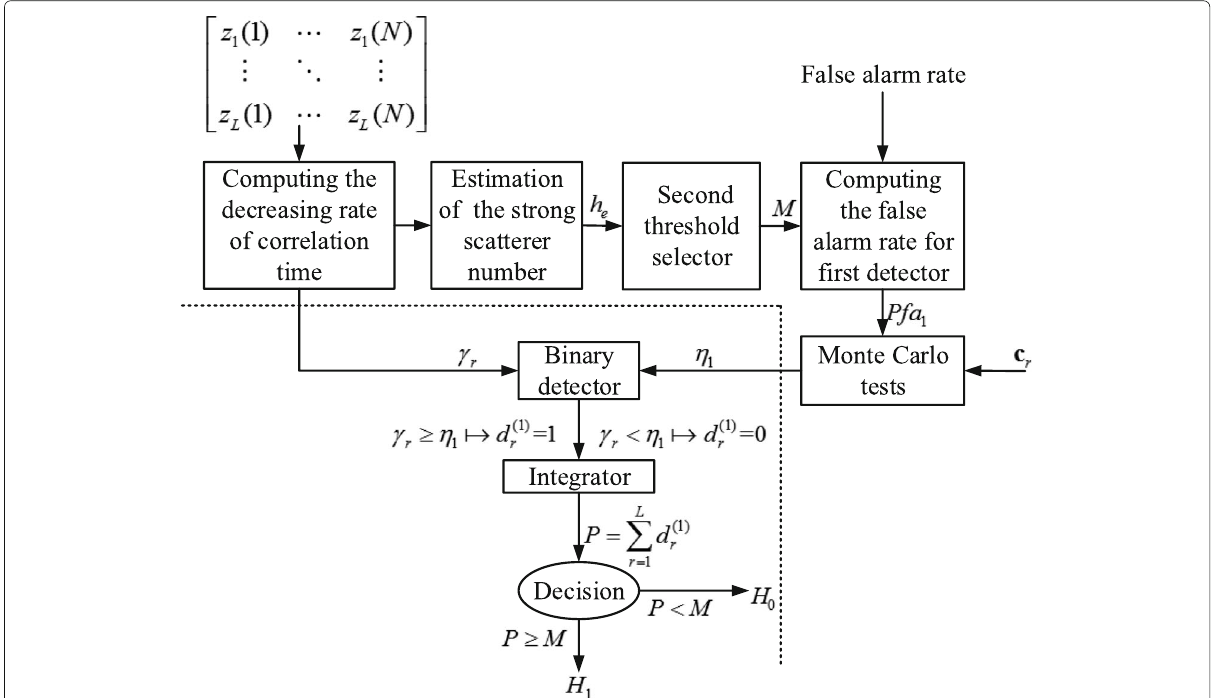
Fig. 5 Flowchart of correlation feature-based